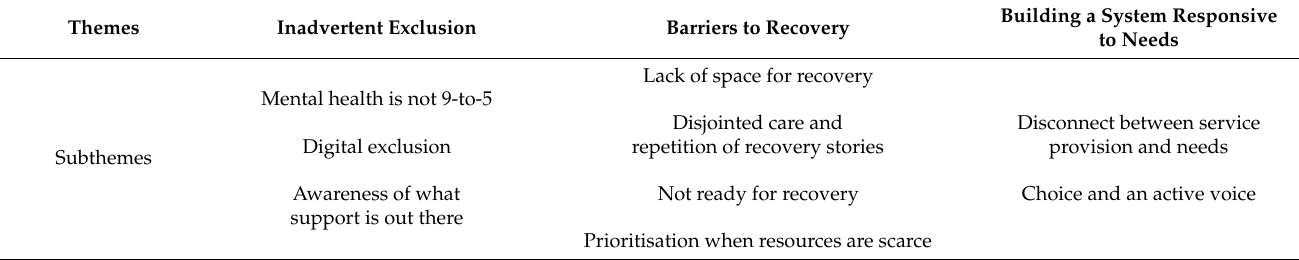
Table 1. Themes and subthemes related to access to community mental health and substance use support for people experiencing homelessness during the COVID-19